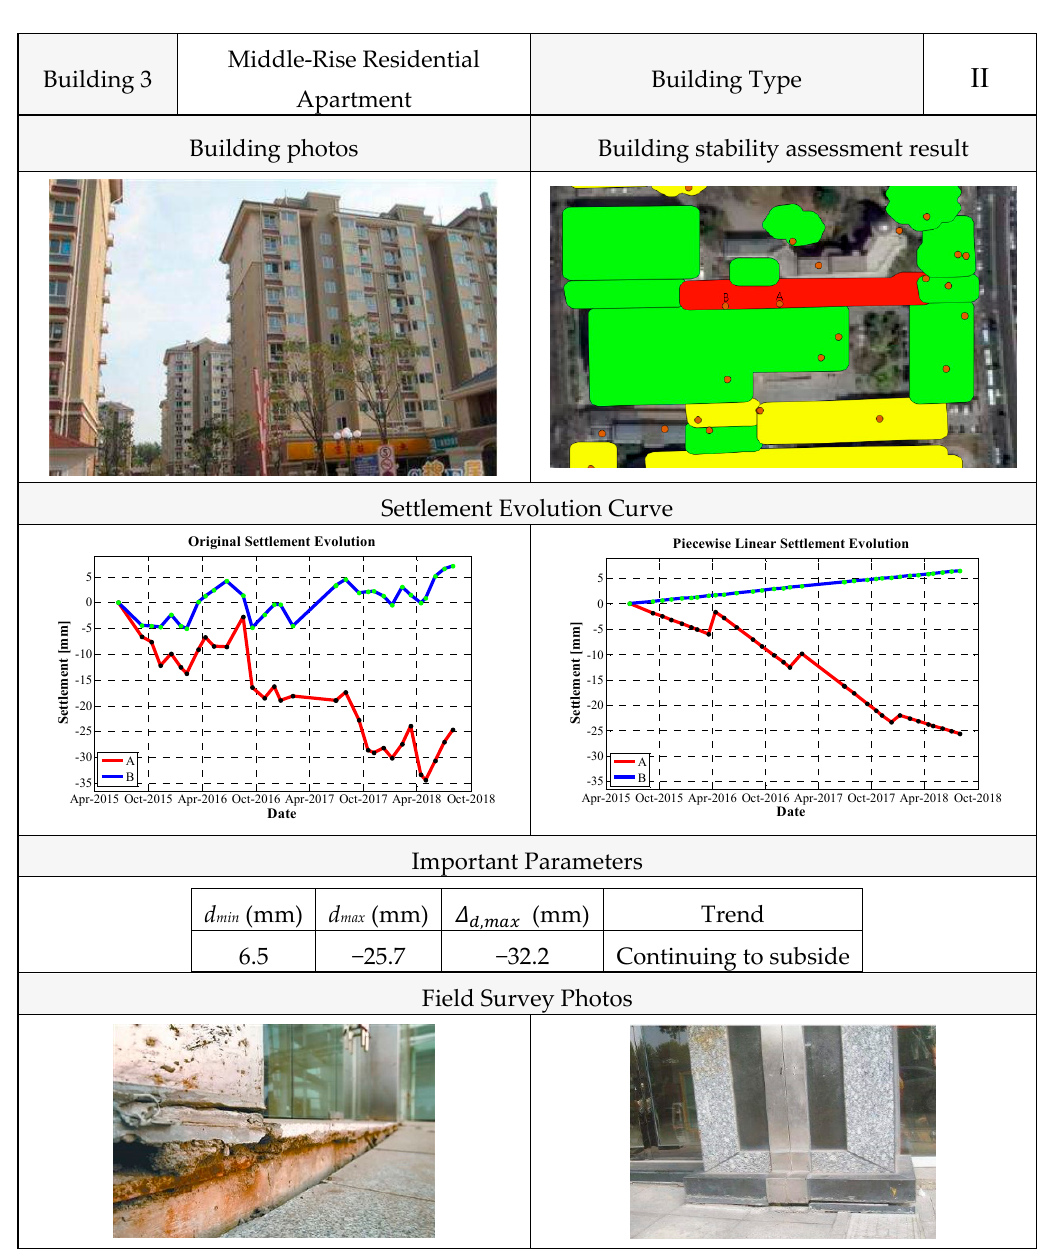
Figure 19. Example of analysis results: Building 3.